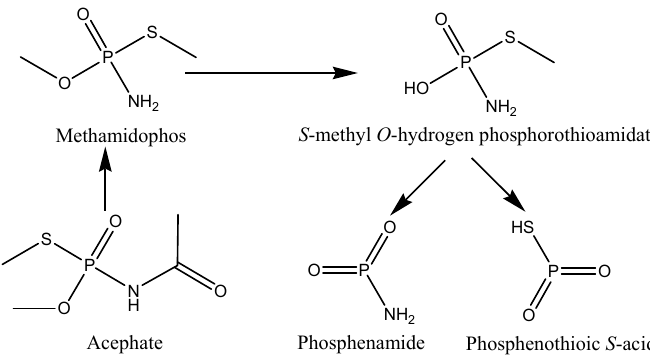
Figure 5. Most probable mechanistic pathway of decomposition of acephate in M9 medium.